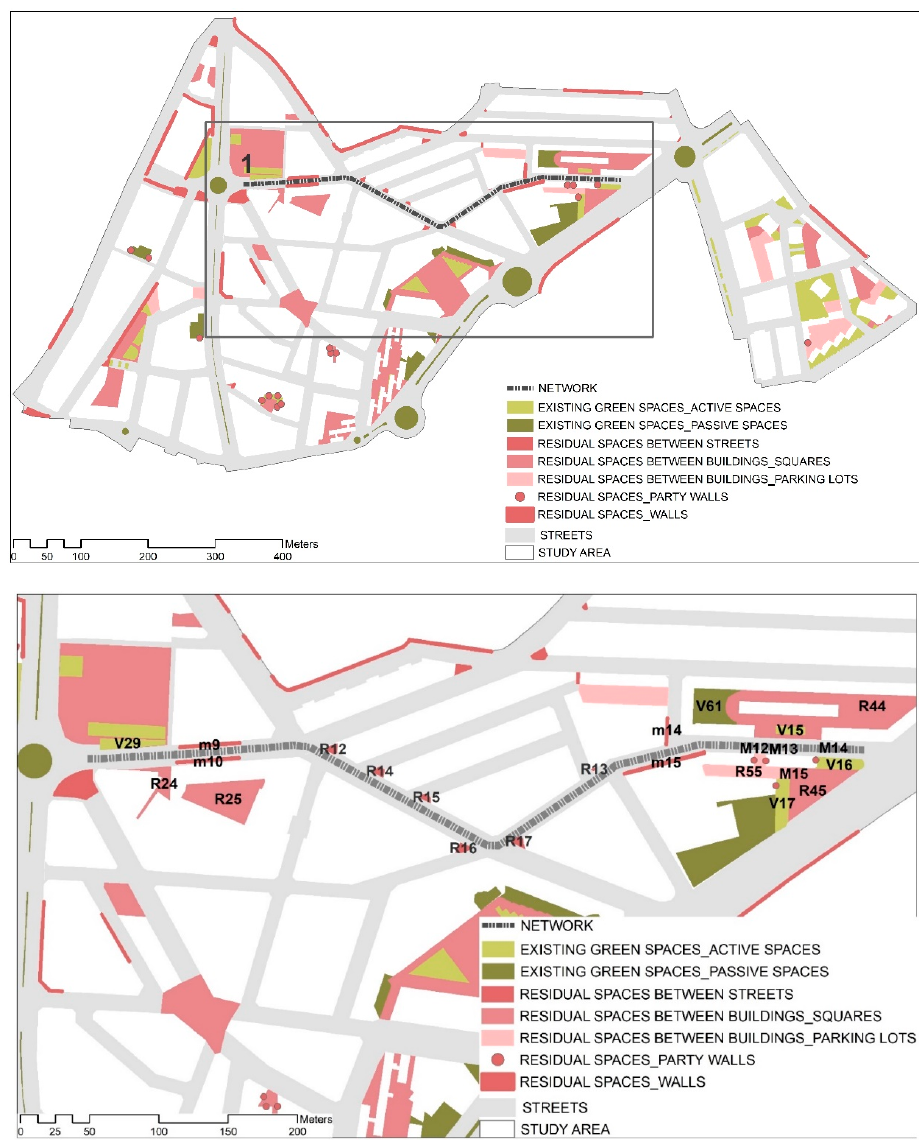
Figure 19. Proposal for a green corridor in La